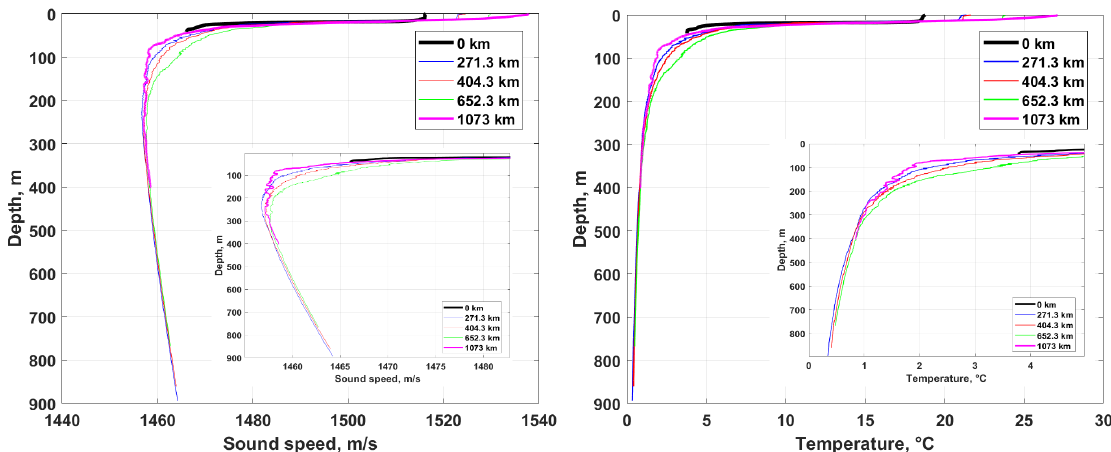
Figure 16. Vertical sound speed ( left ) and temperature ( right ) distributions (measured by CTD-probe) at given points at distances of 271.3, 404.3, 652.5, and 1073 km from the source.